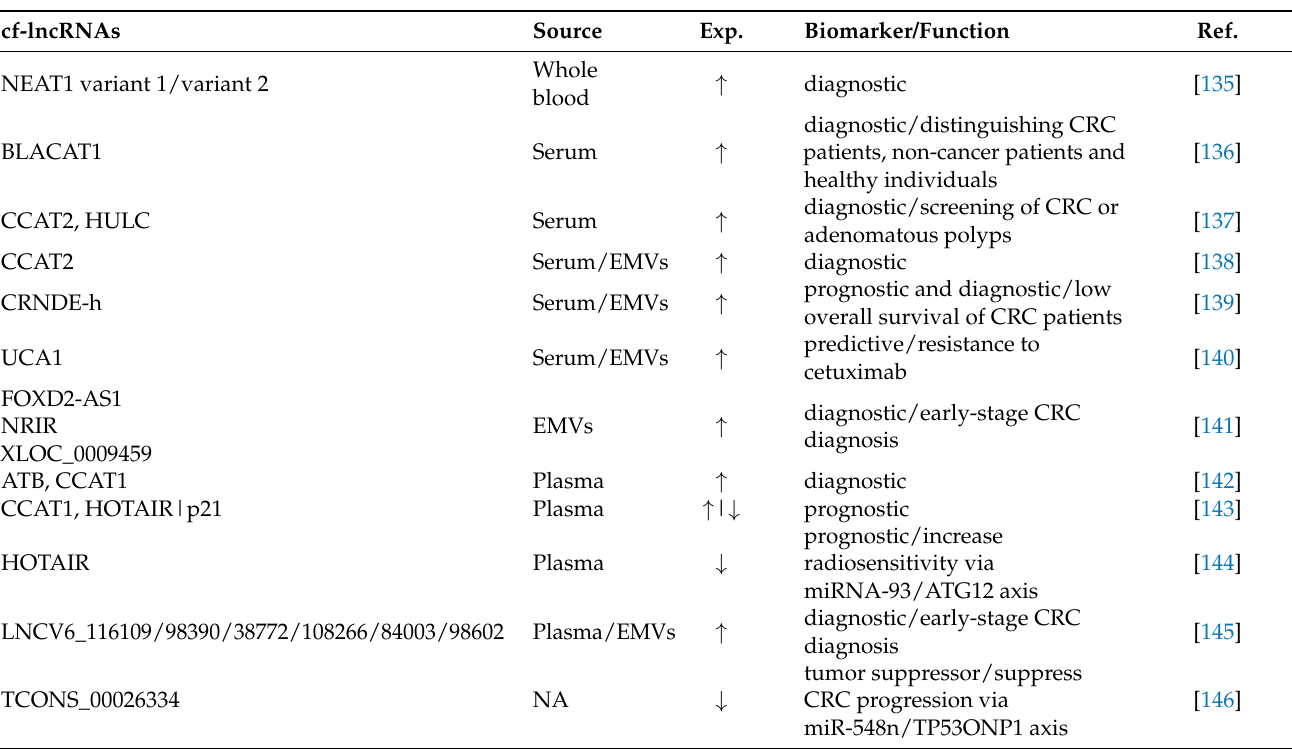
Table 6. List of cf-lncRNAs and their role in CRC. Several lncRNAs are present in EMVs that may be extracted from serum/plasma samples.